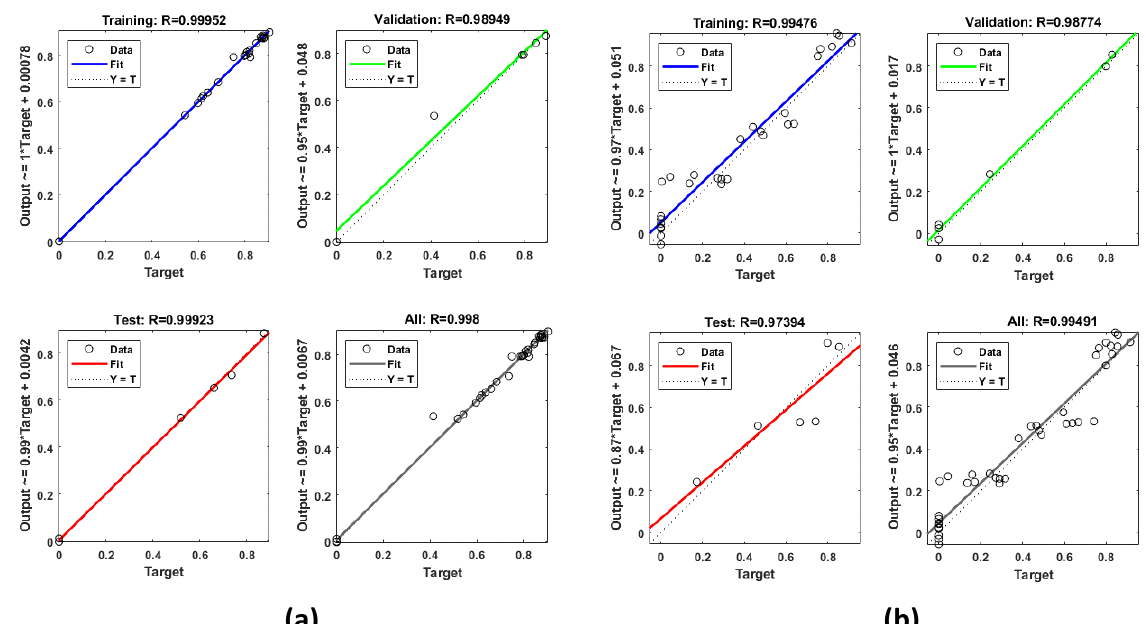
Figure 5. ANN-developed structure for the thermal damage factor.